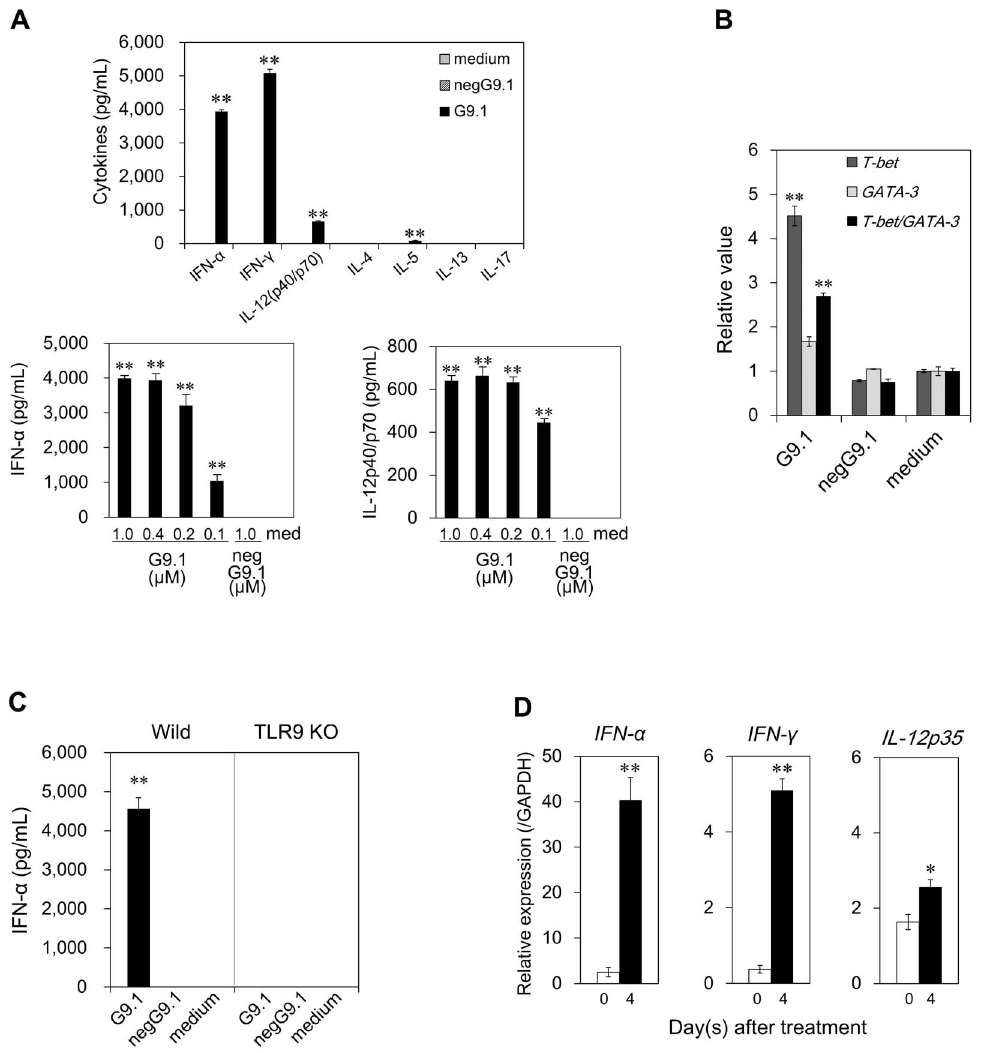
Figure 2. G9.1 upregulated T H 1-related cytokine production and transcription factor expression in mice. AandB , BM cells (5 6 10 6 /mL) prepared from C57BL/6 mice were cultured for 24 h in the medium alone, 0.4 m M G9.1, 0.4 m M negG9.1 (A, upper; B), or with varying